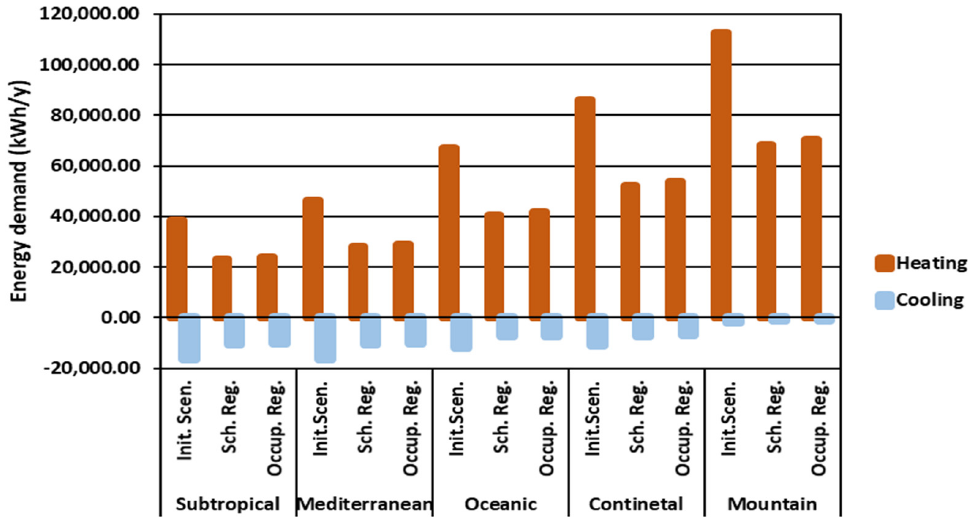
Figure 9. Heating and Cooling Demands of an OR, Using Three Strategies, Located in Different Climatic Zones: Subtropical (A), Mediterranean (B), Oceanic (C), Continental (D) and Mountain (E). As shown in Figure 9, heating consumption is much higher than cooling consumption.